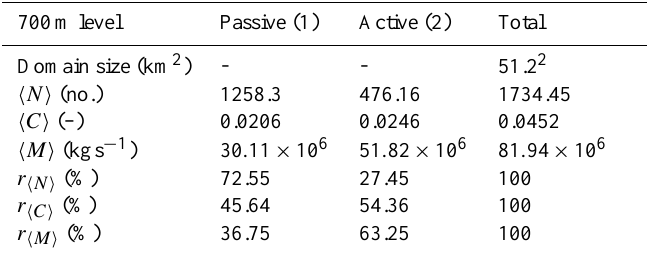
Table 1. Contribution of the different cloud subtypes r (cid:104) N (cid:105) , r (cid:104) C (cid:105) and r (cid:104) M (cid:105) to the total cloud number (cid:104) N (cid:105) , cloud fraction (cid:104) C (cid:105) and vertical mass flux (cid:104) M (cid:105) , respectively. Given results are the time averages for the time frame 6–12h of the LES RICO-140 simulation.